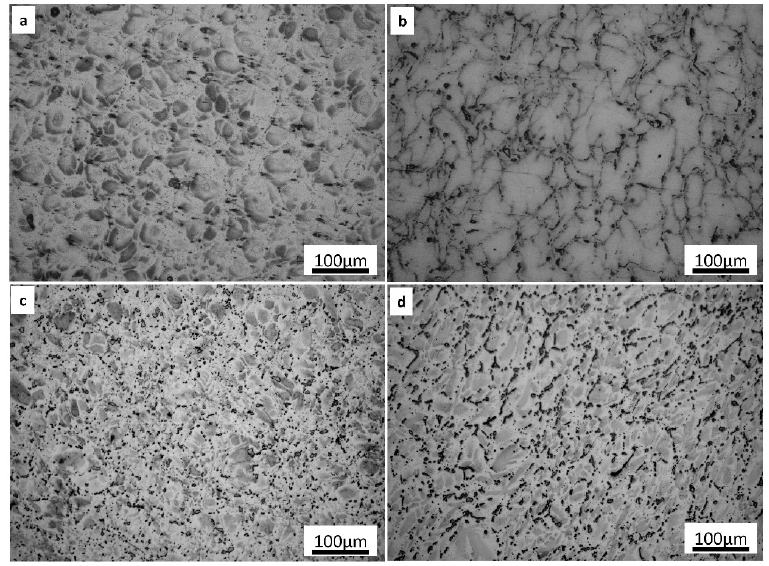
Figure 1. Typical microstructure obtained by optical microscopy of ( a ) Mg-5%Zn; ( b ) Mg-5%Zn-1%Nd;